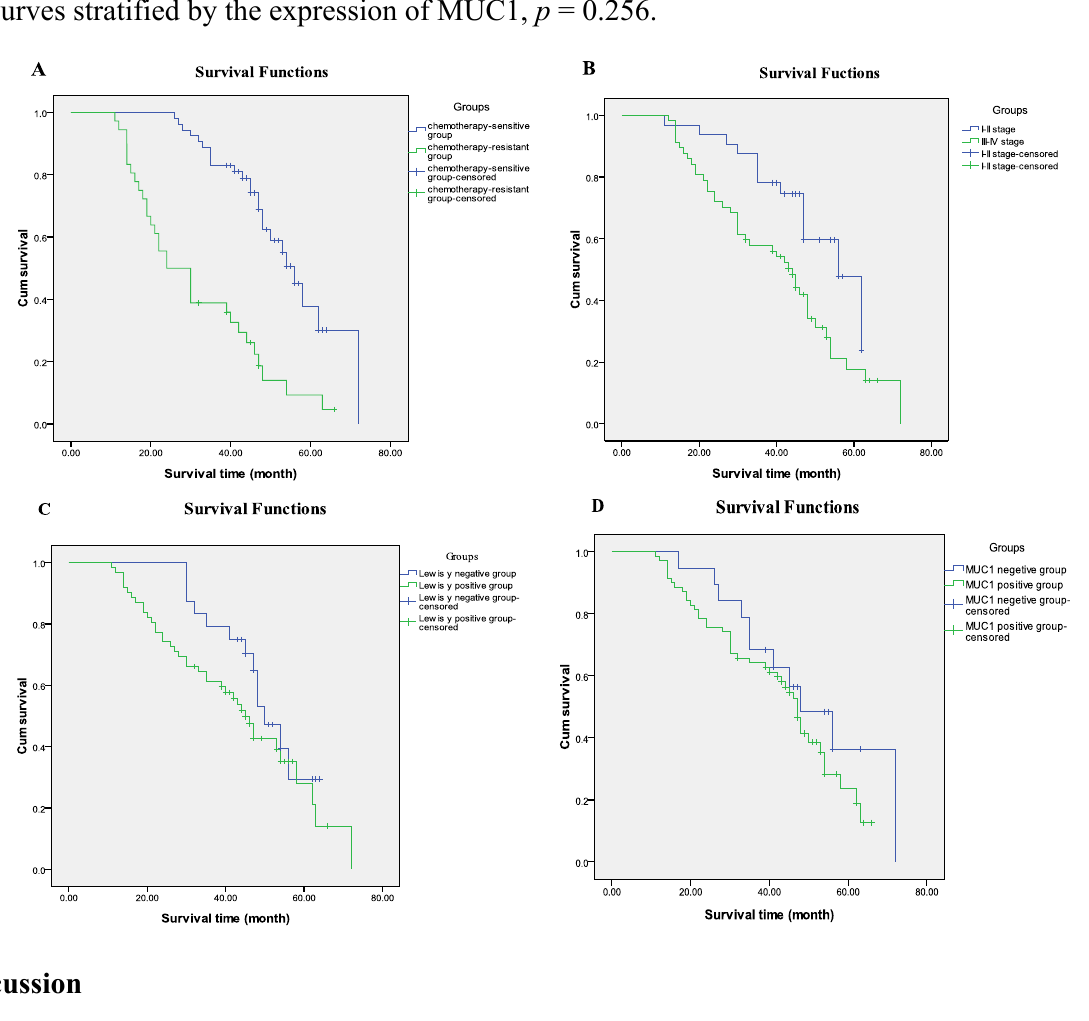
Figure 3. Kaplan-Meier curves (for overall survival) stratified by grouping, using cancer-related deaths as the endpoints. ( A ) Overall survival curves stratified by grouping, n = 92, p < 0.001; ( B ) overall survival curves stratified by stage, p = 0.009; ( C ) overall survival curves stratified by the expression of Lewis y, p = 0.139; ( D ) overall survival curves stratified by the expression of MUC1, p =